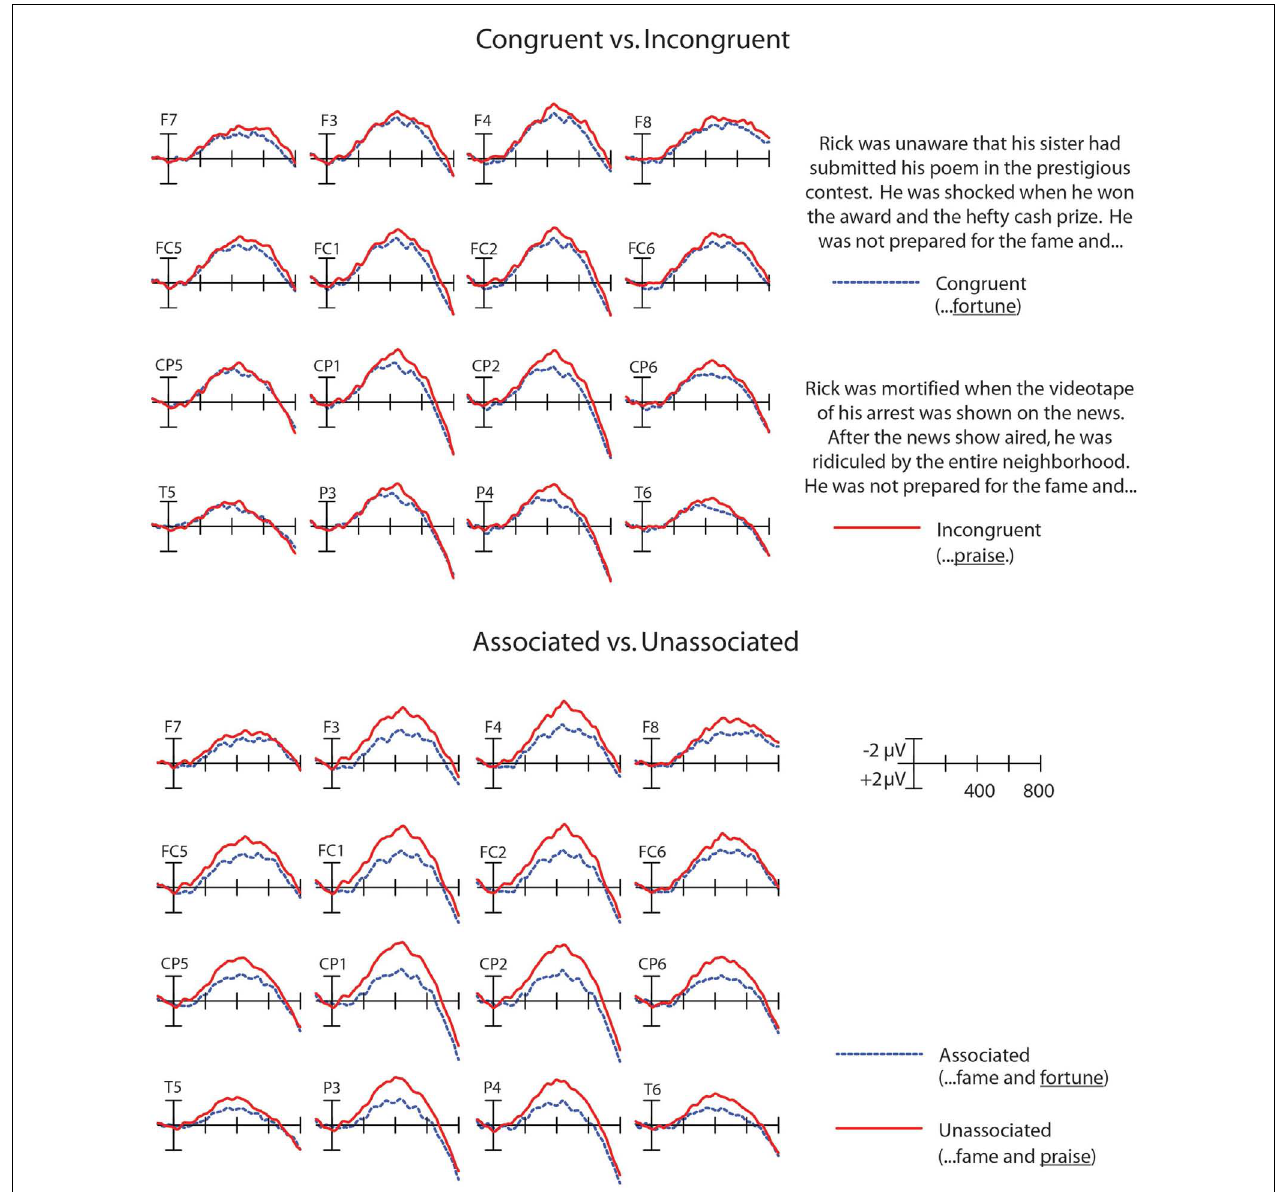
FIGURE 1 | Main effects of congruence (top) and association (bottom) shown for electrodes in all four quadrants: Left/Frontal (F3, F7, FC1, FC5), Right/Frontal (F4, F8, FC2, FC6), Left/Posterior (CP1, CP5, P3,T5), and Right/Posterior (CP2, CP6, P4,T6).